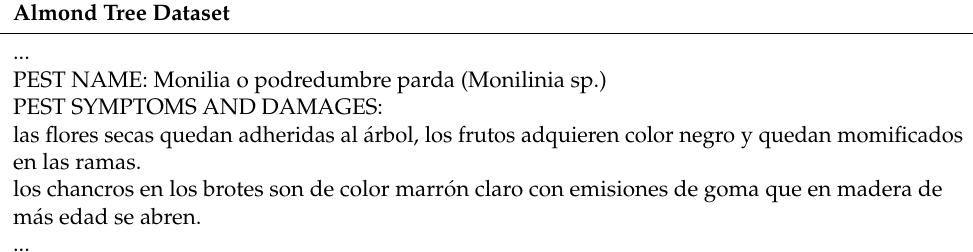
Table 4. Excerpt of the dataset (partially in Spanish).